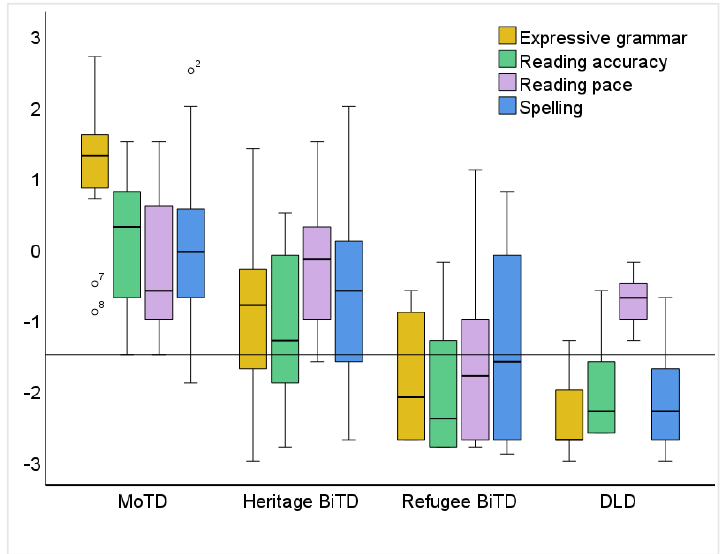
Figure 1. Between-group comparisons on BUEGA subtests (standardized z -scores) with cut-off point specified by the BUEGA manual ( − 1.5 SD